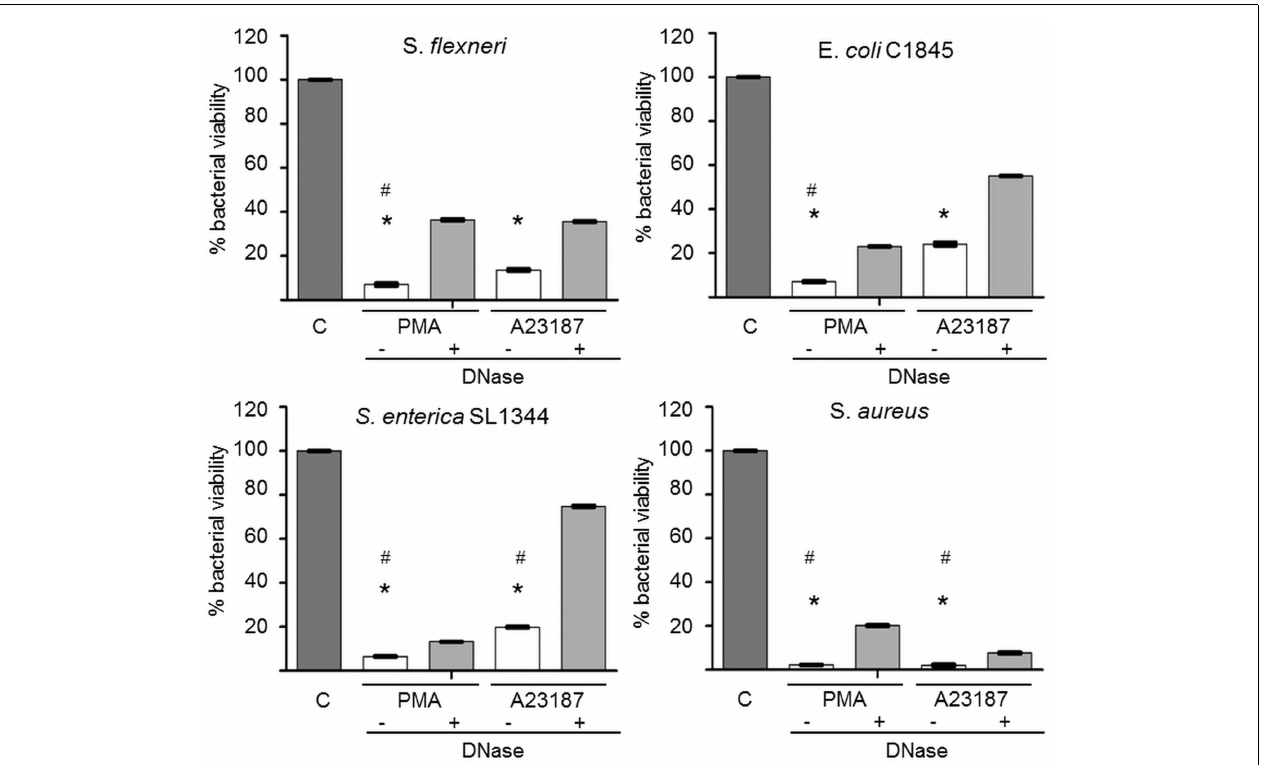
with DNase to dismantle NETs. Bacterial viability was measured by a colony count assay (CFU/mL). Results are expressed as percentage bacterial viability, calculated from CFU/mL values of bacteria exposed to NETs relative to bacteria not exposed to NETs (control tube = C). * p < 0.05 versus bacterial viability in the absence of NETs. # p < 0.05 versus DNase-treated